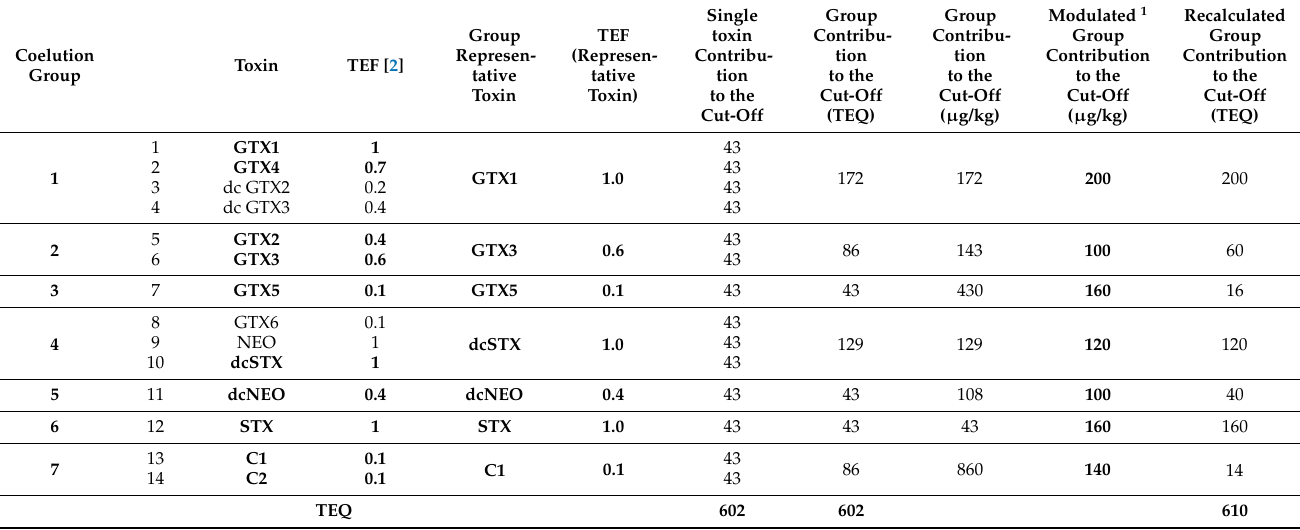
Table 4. Calculation of single toxin contribution to the cut-off (600 µ g STX · 2HCl eqv/kg) for the presence/absence screening